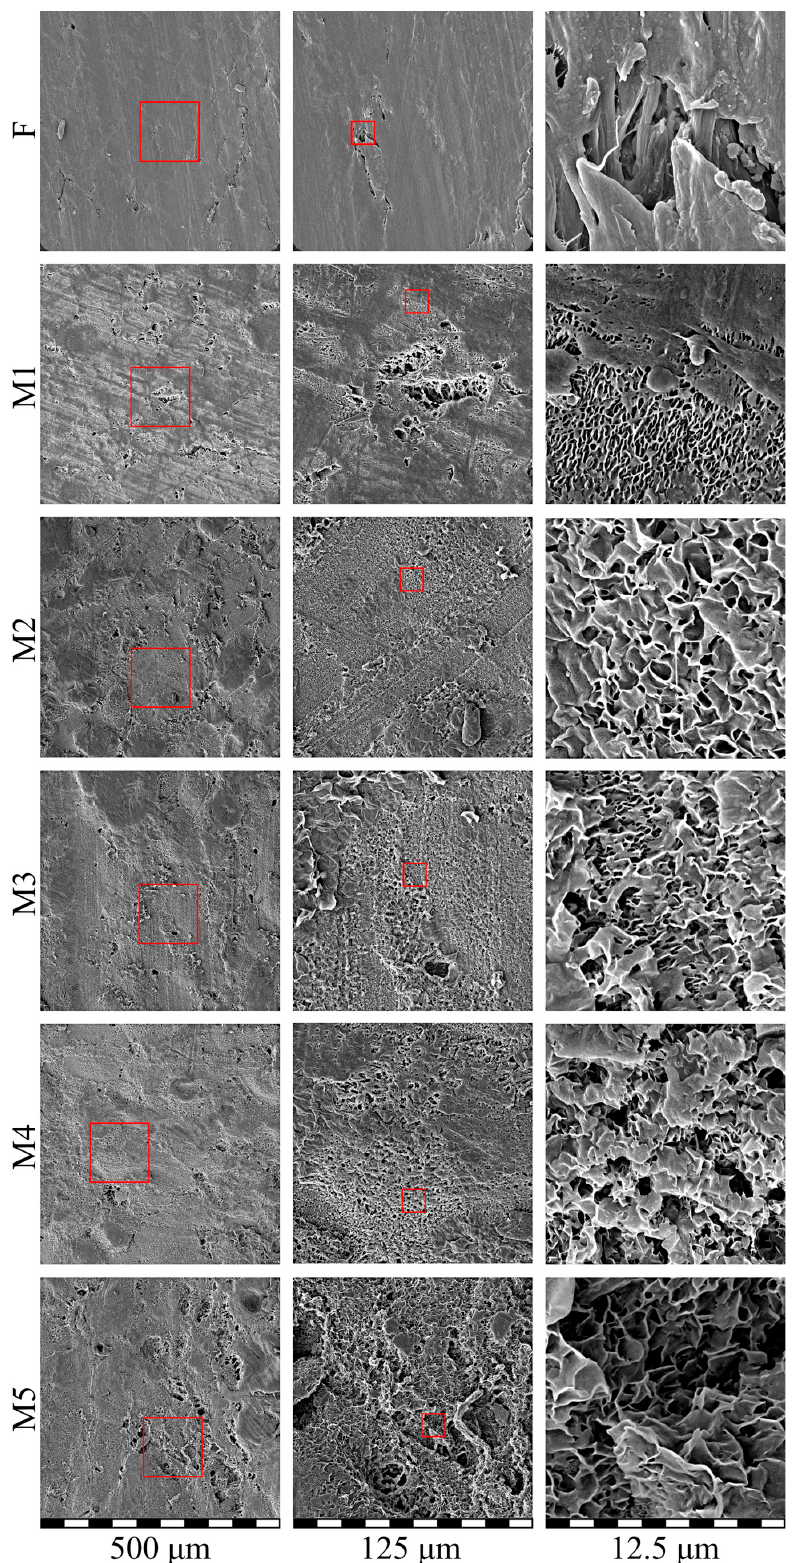
Figure 7. SEM images of the surface of the initial film (F) and membrane samples (M1–M5). Red squares highlight the regions where higher magnification images (shown to the left) were taken.